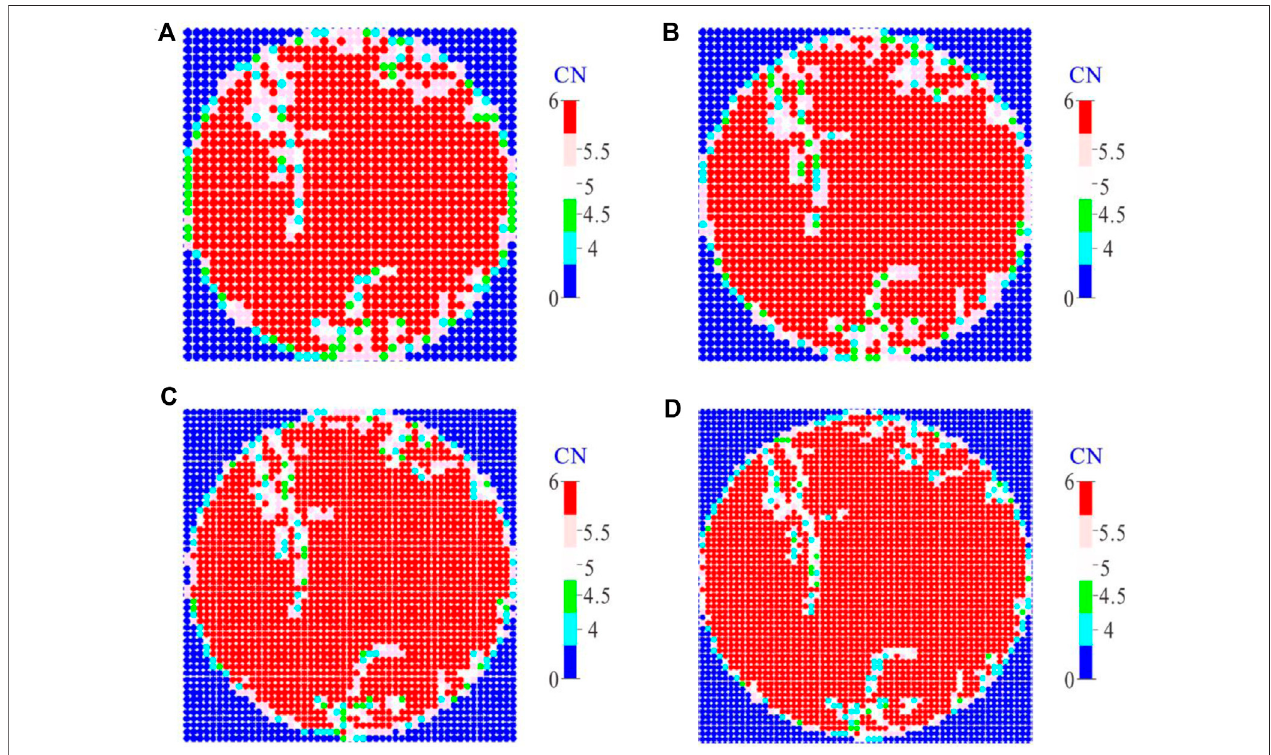
(cid:2) 0 . 9. (B) R w (cid:2) 0 . 8. (C) R w (cid:2) 0 . 7. (D) R w (cid:2) 0 . 6. 2R 2R 2R 2R